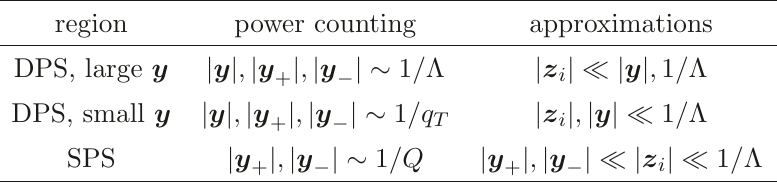
Table 1. Regions of y discussed in the text. For power counting, the subtraction term is simply T r T is good up to power corrections in Λ /Q in its design region r , then